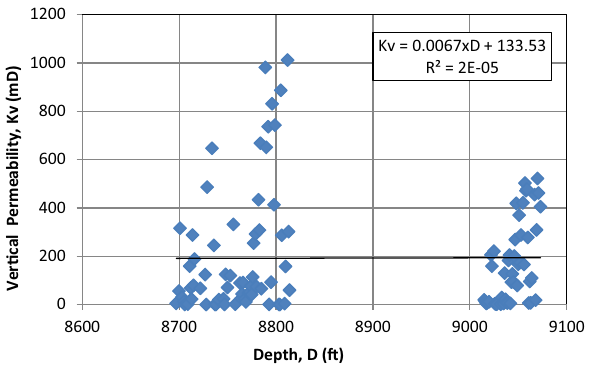
Fig. 3 Horizontal permeability and porosity relationship